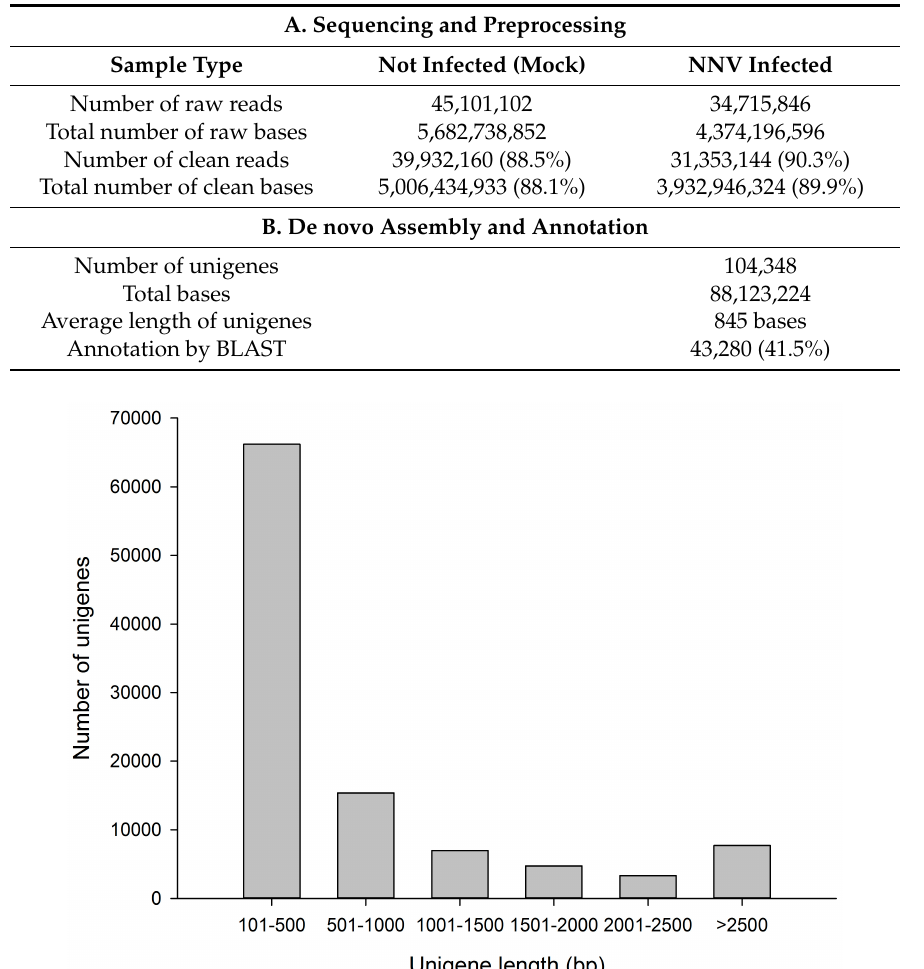
Table 1. Sequencing, assembly and annotation of transcriptome.